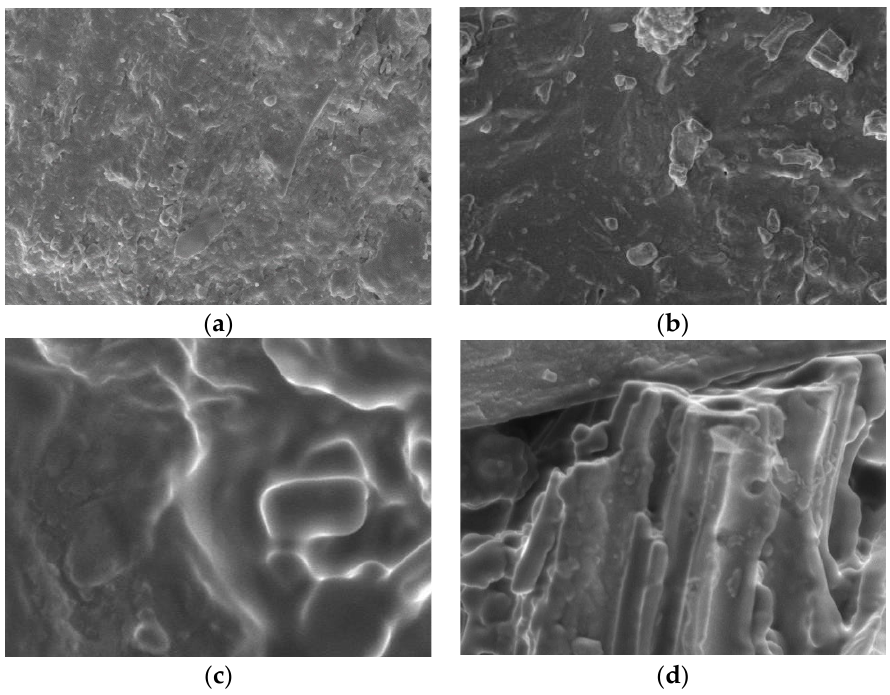
Figure 6. SEM morphology of: ( a ) unmodified membrane adsorber without HCL activation (AC); ( b ) activated membrane adsorber using g 0.5 M; ( c ) 1 M; ( d ) 1.5 M HCl.